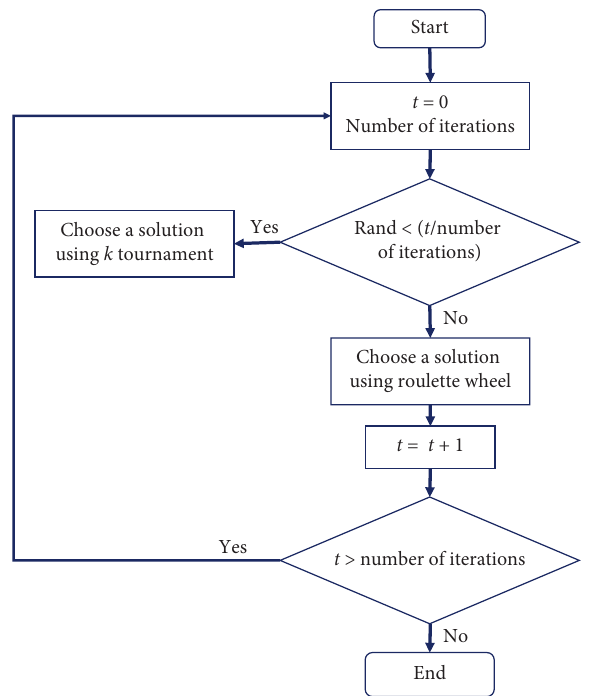
Figure 5: Selection of solutions using roulette and k-tournament